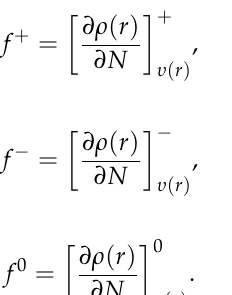
Figure 8. MEP surface at ρ (r) = 4.0 × 10 − 4 electrons/Bohr 3 contour of the total SCF electronic density for glutathione molecule at the M06-2X/6-311++G(d,p) level of theory. To determine the local electrophilicity, the Fukui function [37,38] was used to predict the regions of nucleophilic,